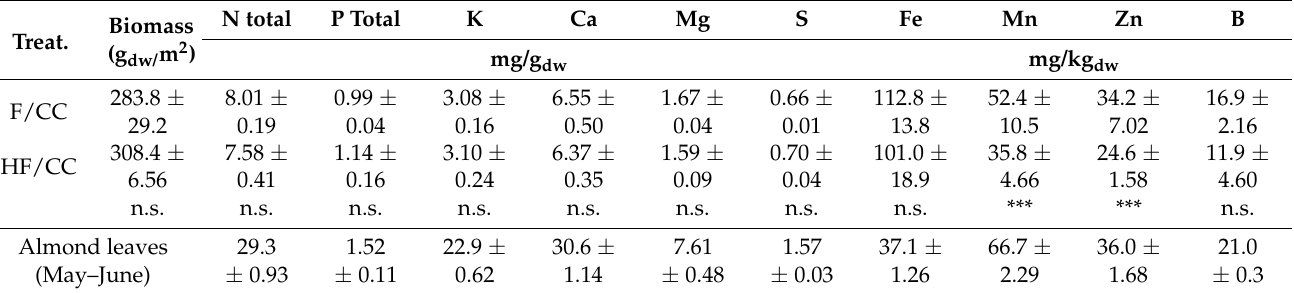
Table 3. Effects of the fertigation dose (farmer (F) and half farmer (HF)) on the biomass production of the cover crops (CC) and concentration of mineral nutrients at the end of the experiment (20 October 2020). The leaf mineral concentration in the almond, averaging the May and June sampling, is also shown. Data shows mean ± standard error.